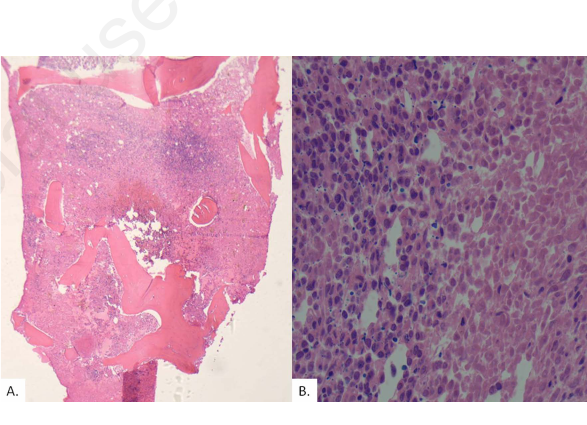
Figure 2. Bone marrow biopsy demonstrating severe bone mar- row necrosis. Diffuse bone marrow necrosis is necrosis of myeloid tissue and medullary stroma in large areas of the hematopoetic space on a biopsy, and is characterized by disrup- tion of the normal bone marrow architecture with considerable loss of fat spaces (image A), but normal cortical bone. Notice in image B that all cell lines (including red cell and platelet precur- sors) have been